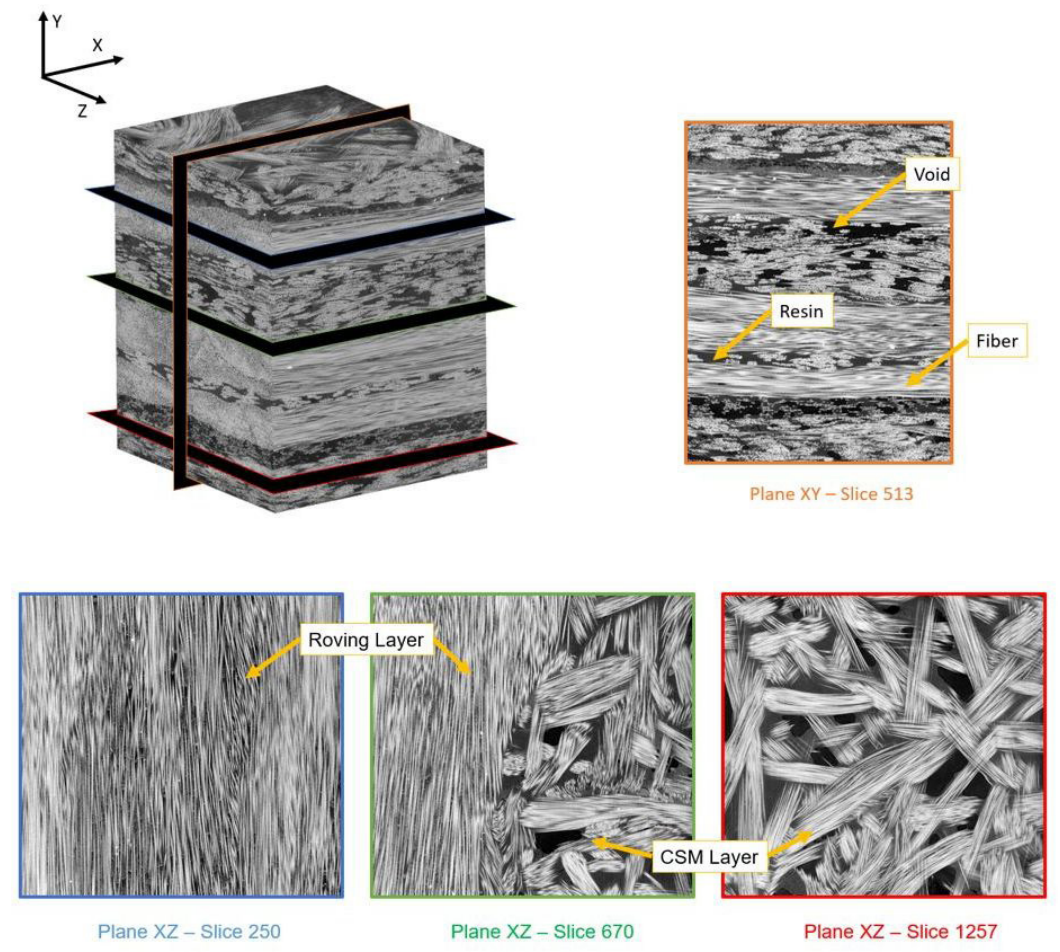
Figure 4. Micro-CT image of a pultruded GFRP sample with different 2D slices to emphasize the heterogeneity of the sample and its constituents, i.e., to show how difficult it is to separate the layers. Table 2. Segmentations for the correspondent micro-CT images and the respective labeled phases.